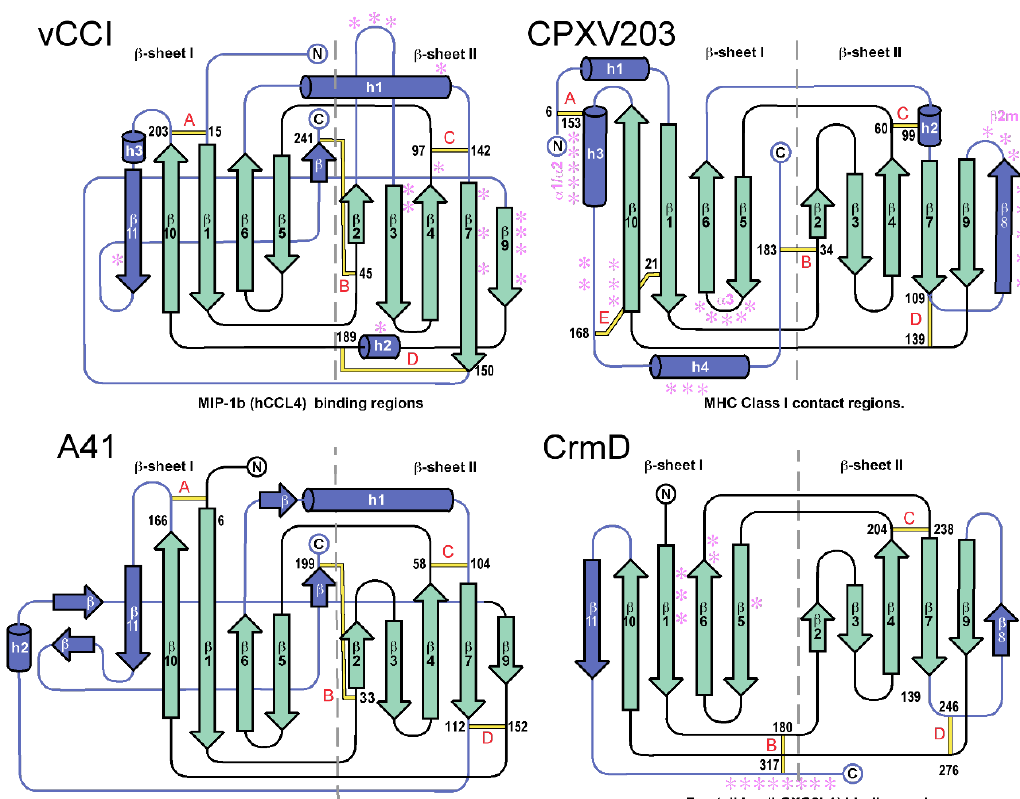
Figure 2. PIE domain connectivity diagrams highlighting the conserved core β -sheet architecture (cyan) and unique connecting decorations (dark blue). The disulfide bonds are labeled in red (A–E). Ligand contact regions are annotated with magenta stars for those PIE domains with structurally defined interactions.